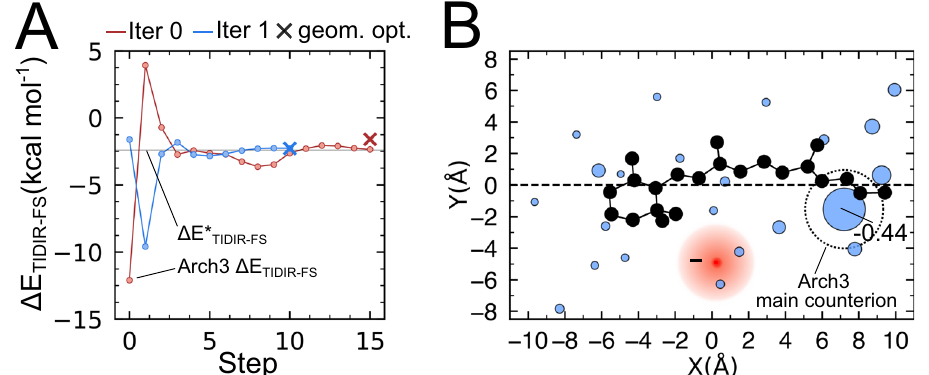
Δ E Δ E TIDIR-FS is recomputed. If the difference between the TIDIR-FS calculated after part ii and Δ E* TIDIR-FS is above a selected threshold, i-ii are repeated. The circles indicate the steps of part i, and the crosses indicate the results of geometrical relaxation of part ii. B Final charge distribution obtained after convergence of the optimization above. Two-dimensional representation of the fraction of negative charges residing in the cavity residues is proportional to the radius of the blue circles (the main counterion D222 fi nal charge is indicated). The barycenter of the correspondingnegativechargeisshownasaredcircle.TheoriginallocalizedArch3 negative charge is indicated by the large open circle centered at the original counterion position Source data are provided in the Source Data fi le (a,